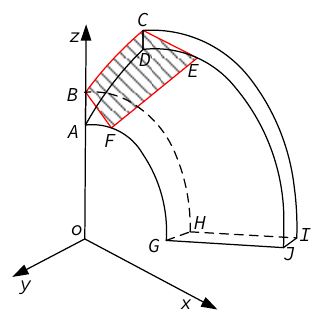
Figure 6. The model of broken rock.